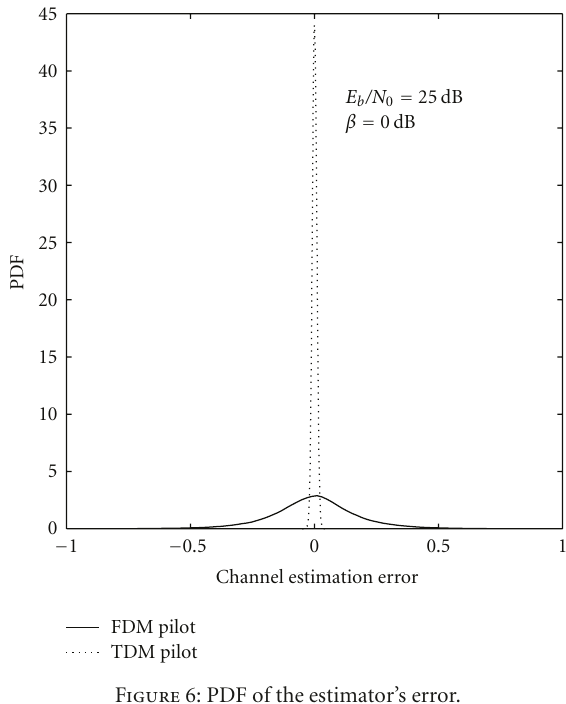
Figure 6: PDF of the estimator’s